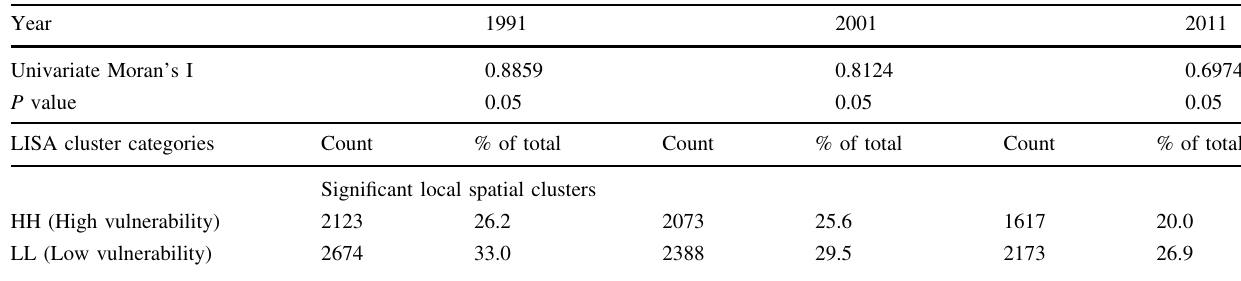
Fig. 5 Italy’s changing social vulnerability as shown by univariate Moran’s I LISA cluster maps for social vulnerability at the municipality level: a 1991; b 2001; and c 2011. Significance of the Table 4 Spatial correlation between the SVI in different years at the national level in